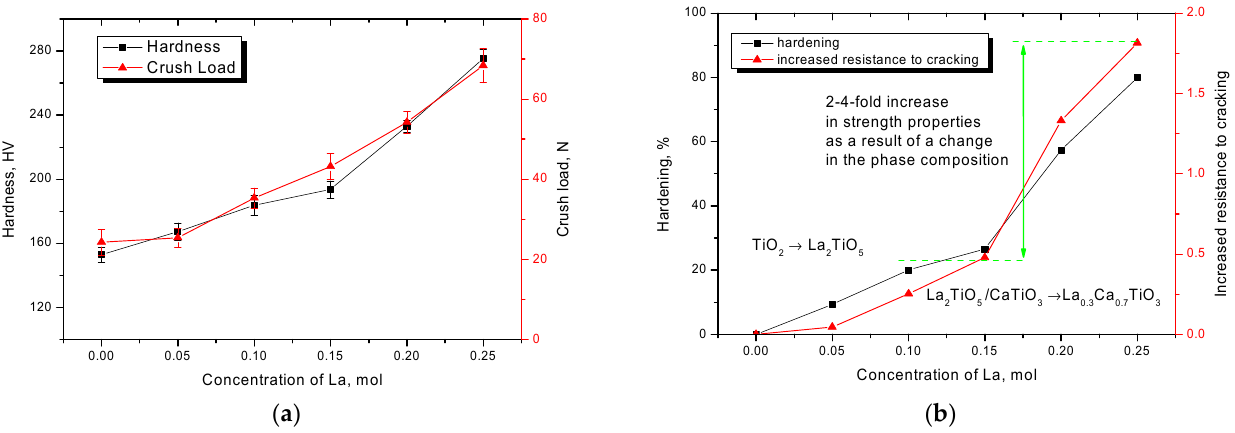
Figure 5. ( a ) Results of changes in hardness and crack resistance of ceramics; ( b ) Diagram of hard- ening of ceramics depending on phase composition. of ceramics depending on phase composition.